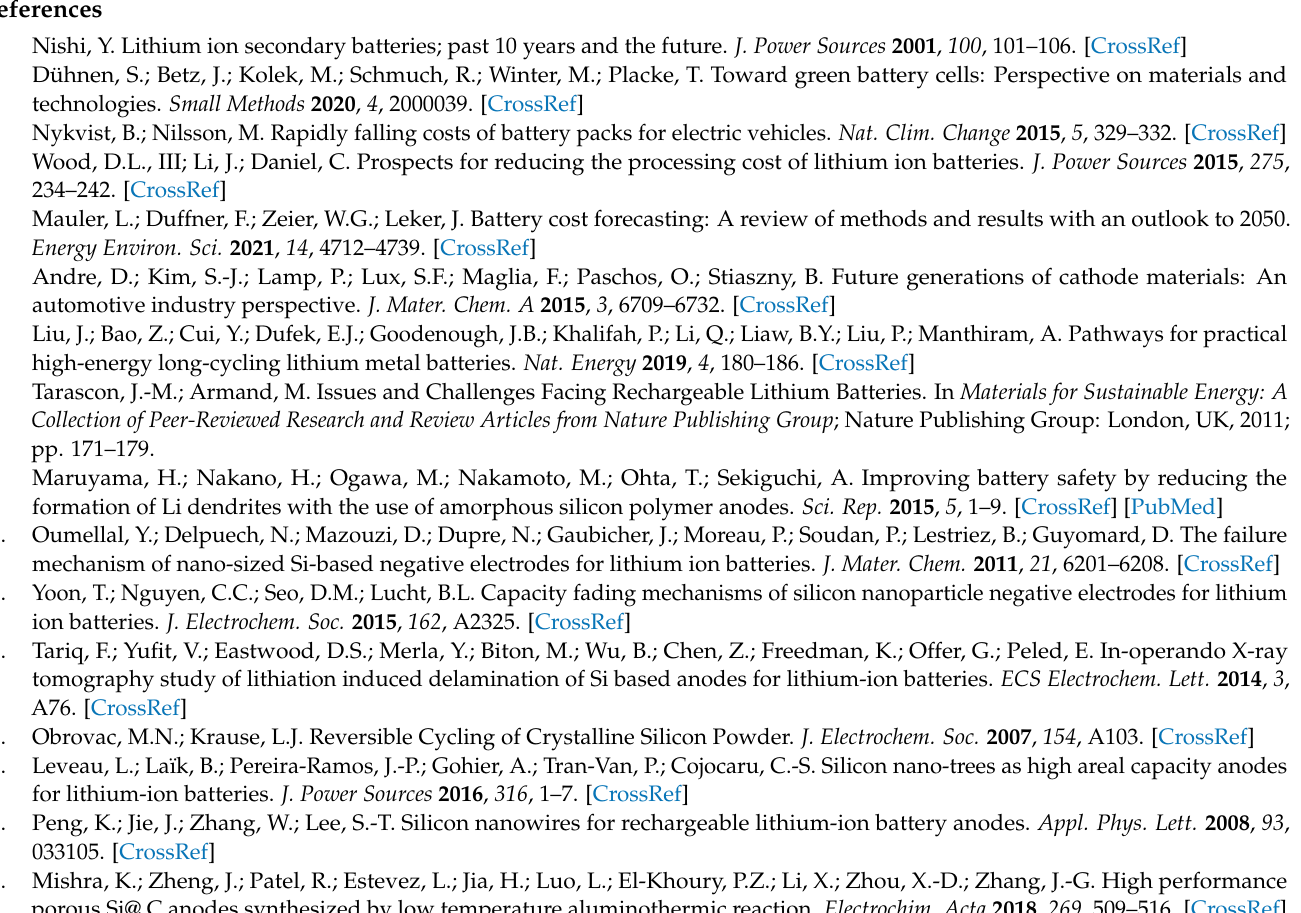
Figure A1. Galvanostatic result of cells with structured (LS) silicon electrodes (type 1 in Table 1).